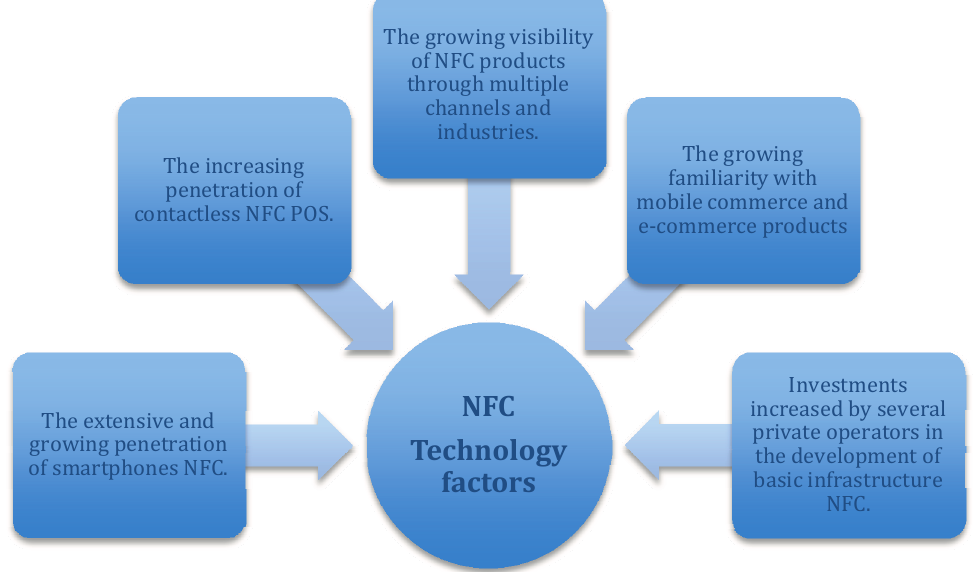
Figure 5. Example of some of the main NFC technology factors (authors’